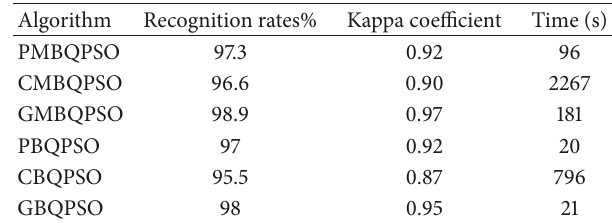
Table 4: Comparison of whole image’s subpixel mapping results of six